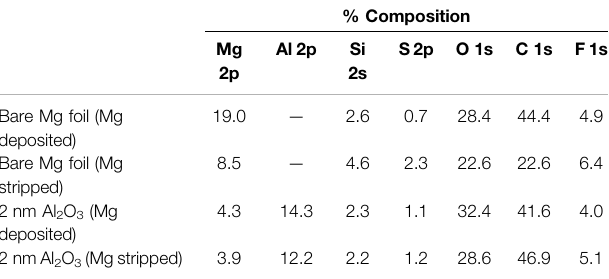
TABLE 1 | Atomic composition from XPS analysis of cycled Mg foil